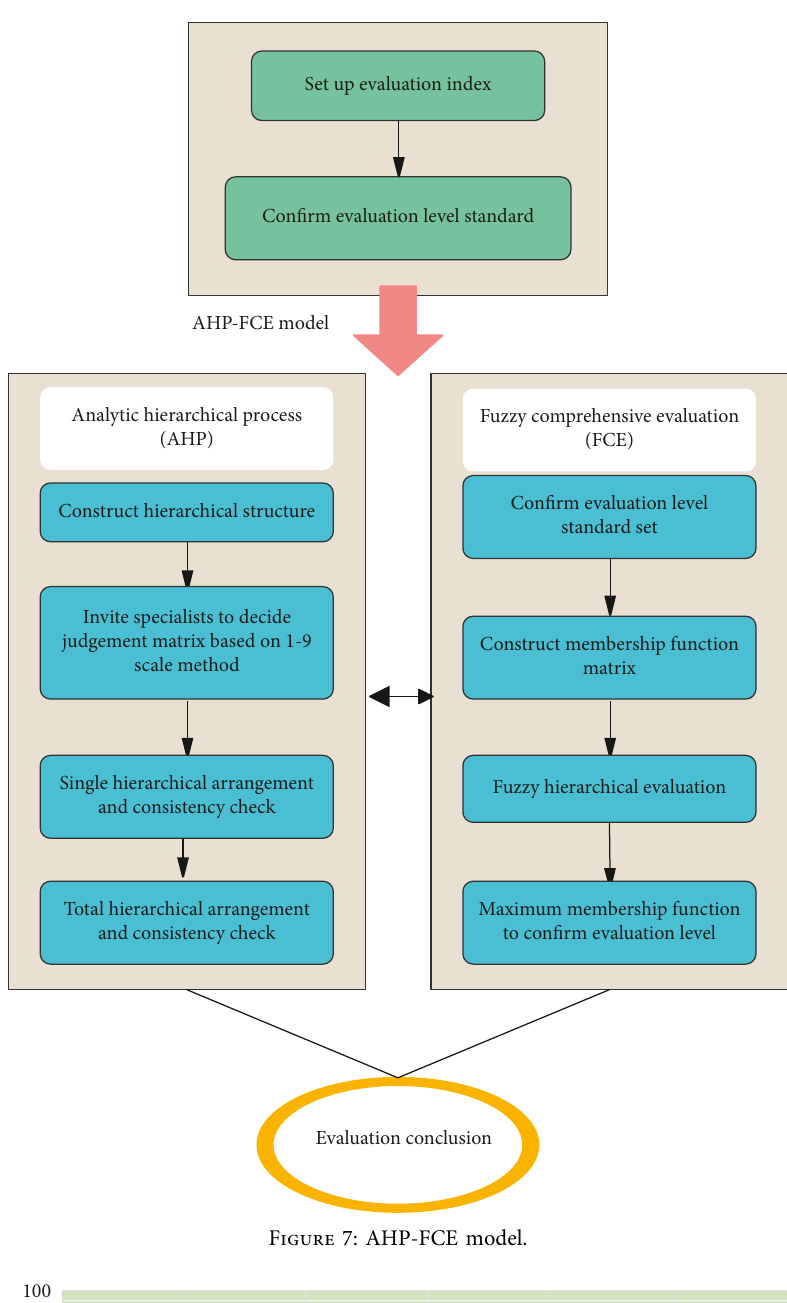
Figure 7: AHP-FCE model.